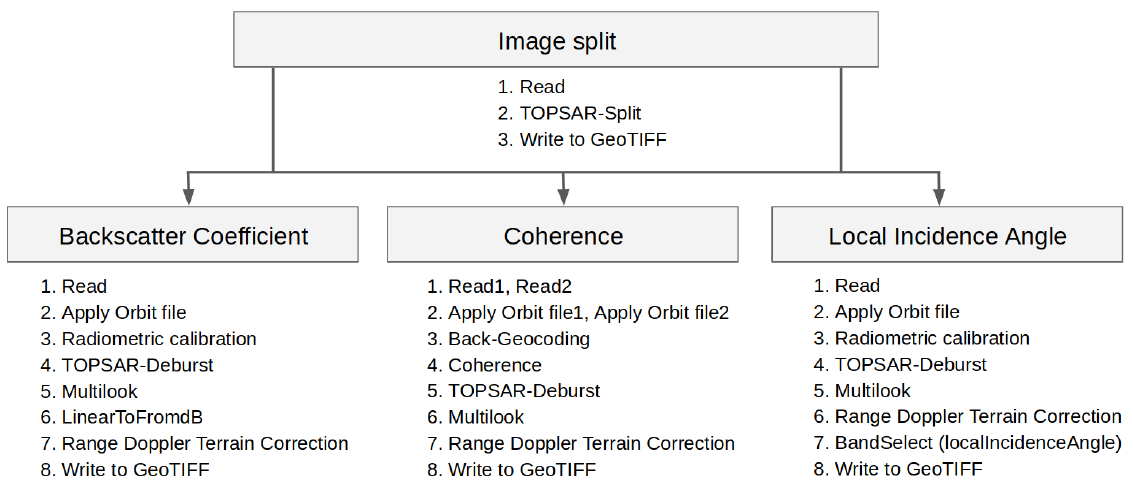
Figure 4. Data processing chain of Sentinel-1 radar